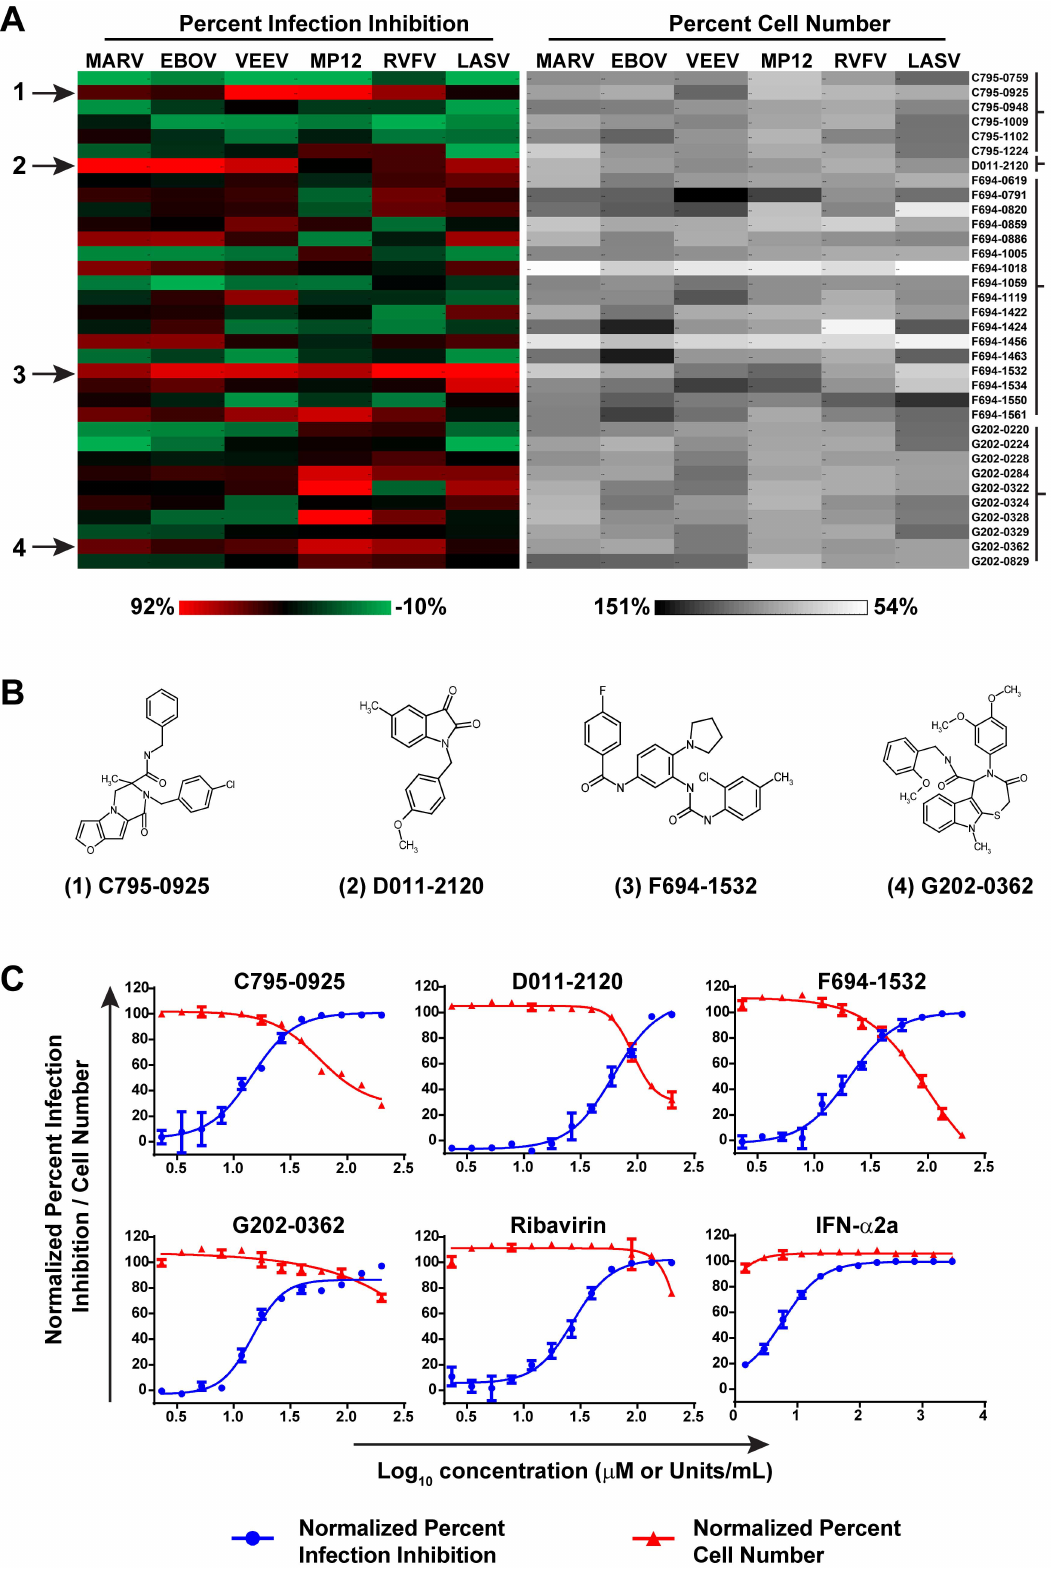
Figure 3. Secondary screening of hit compounds against multiple RNA viruses and validation determined by dose response curve analysis of lead compounds and reference compounds. ( A ) Heat map showing relative percent infection inhibition (left panel) and percent cell number (right panel) of compounds (10 m M concentrations) against multiple RNA viruses. The four hit compounds are marked with arrows ( A )